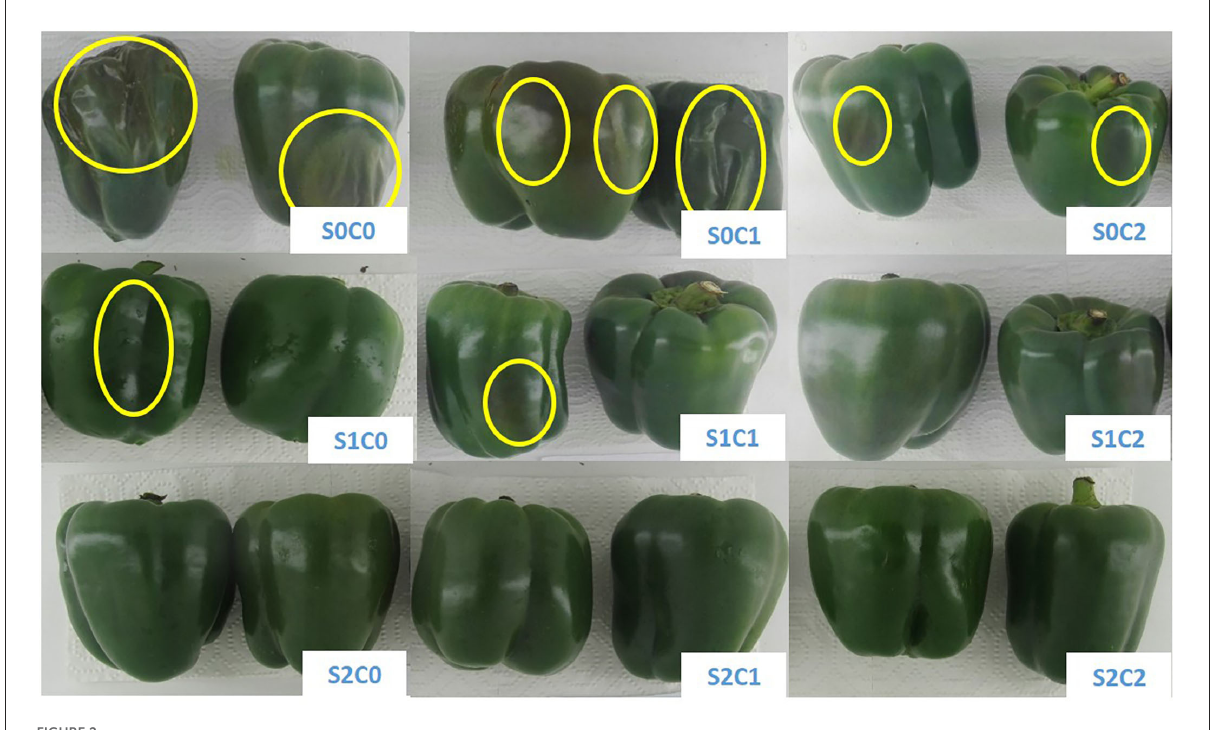
FIGURE2 Sweet pepper fruit after 60 d of storage period at 4 ± 2 ◦ C plus shelf life (2 d, 20 ◦